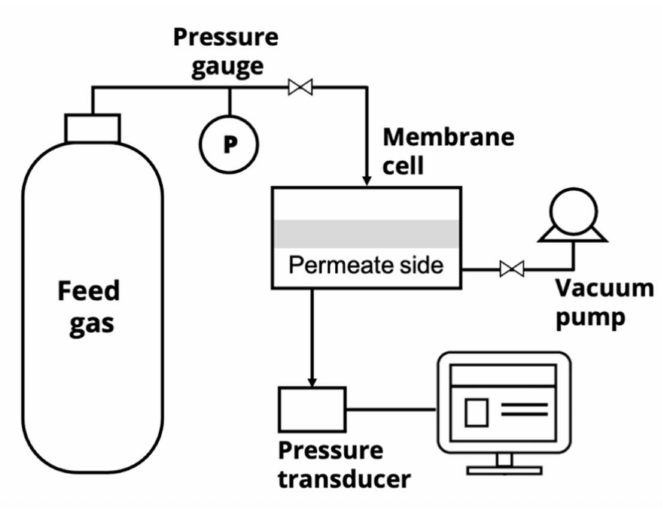
Figure 13. Schematic of the laboratory-scale gas permeation